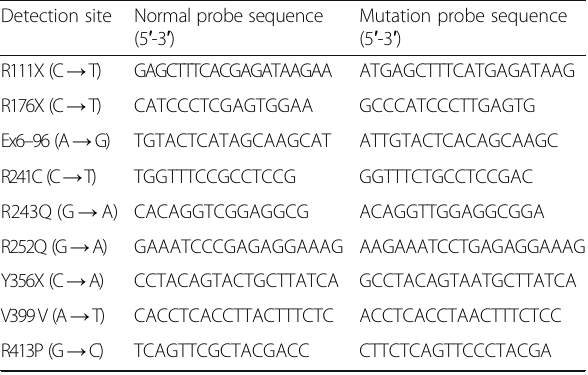
Table 2 Sequence of site detection